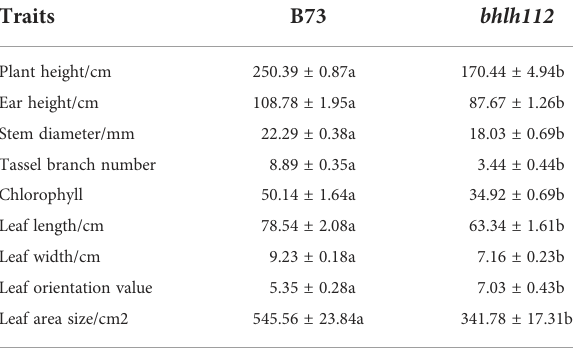
a, b indicated signi fi cant differences between materials. P <